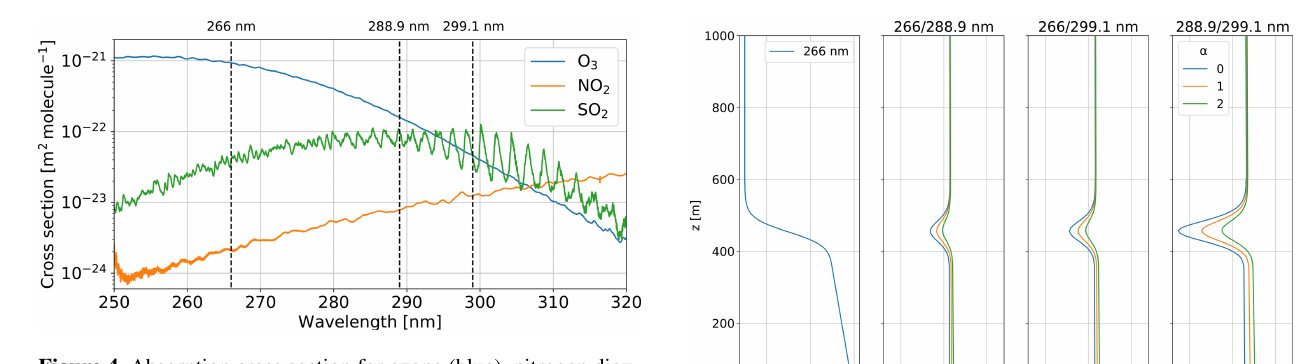
Figure 4. Absorption cross section for ozone (blue), nitrogen diox- ide (green) and sulfur dioxide (orange) in the UV region of the spectrum (300K; 775hPa). Wavelengths transmitted by TMTOL are also shown (black dashed lines).